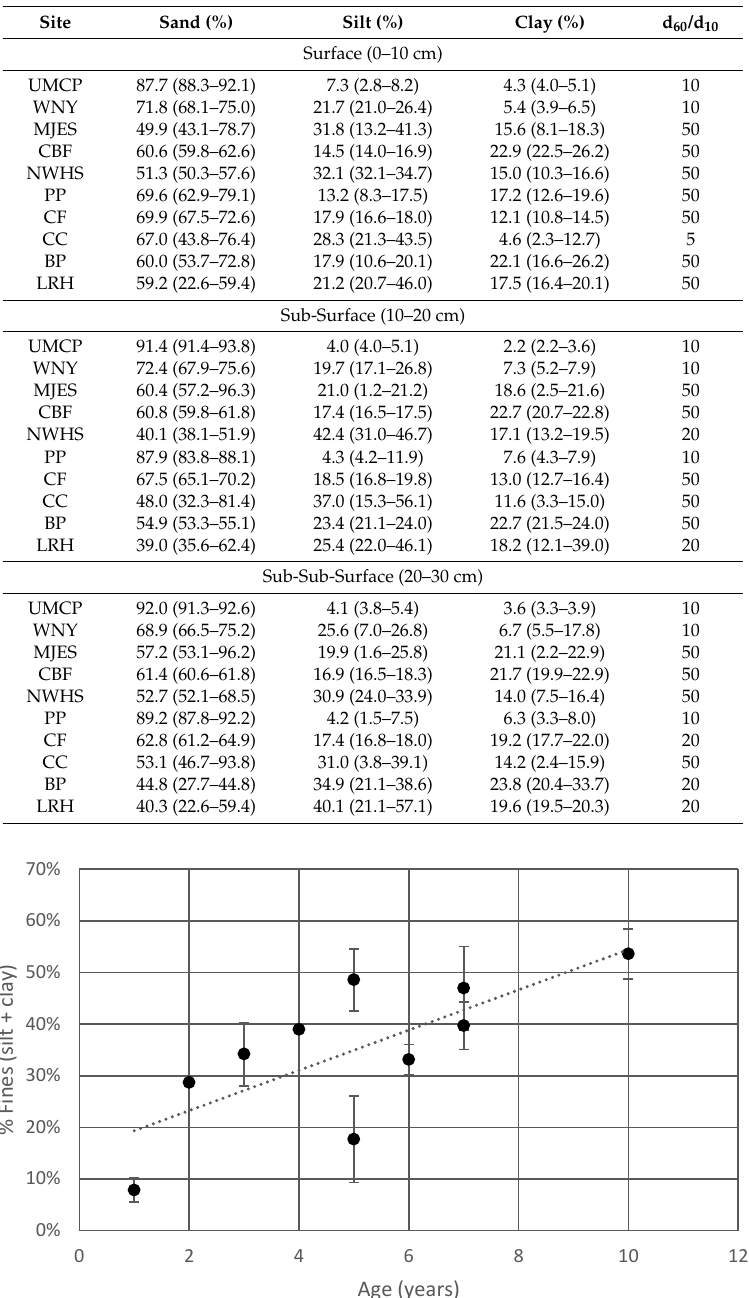
Table 2. Particle size analysis, separated into United States Department of Agriculture (USDA) textural classes. Reported as median (range).